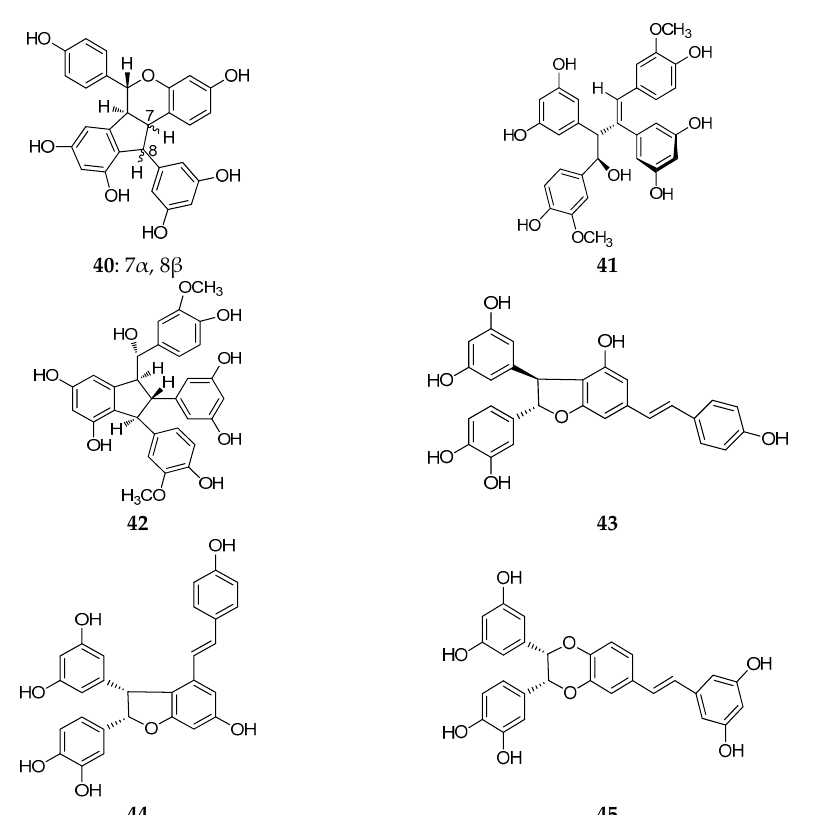
Figure 3. The structures of resveratrol dimers ( 7 – 45 ).